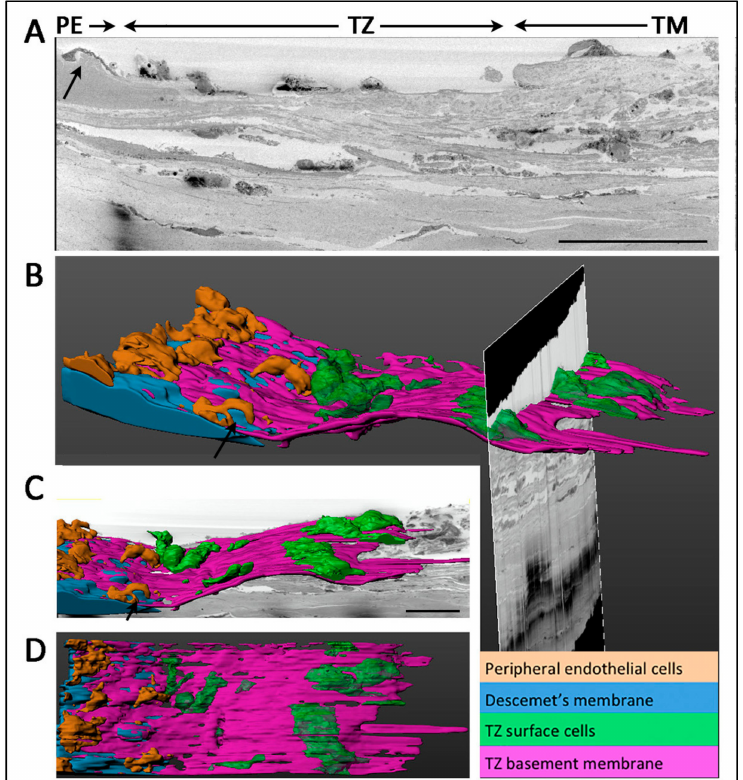
Figure 7. Serial block face-scanning electron microscopy of junction between transition zone (TZ) and peripheral endothelium (PE) and 3D reconstruction. ( A ) Representative TEM slice showing an overview of PE / TZ junction. Arrows show the presence of Hassall-Henle structure at extreme peripheral Descemet’s membrane (DM). ( B ) 3D reconstructed image of TZ / PE junction showing DM insertion below TZ surface. ( C ) 3D reconstructed image showing TZ surface cells. ( D ) En face view showing the distribution of PE and TZ surface cells. Scale bars: 50 µ